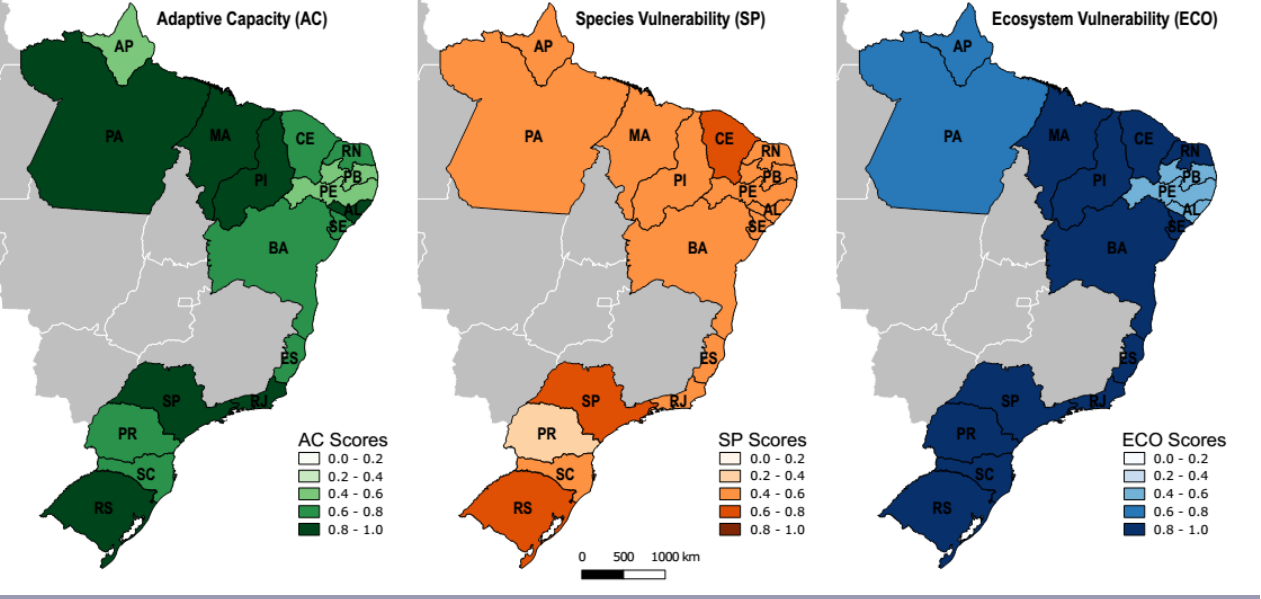
Fig. 4 . Maps with all coastal states colored by final Index of Coastal Vulnerability (ICV) component scores: adaptive capacity (green scale), species vulnerability (orange scale), and ecosystem vulnerability (blue scale). All component scores were divided into 5 categories, with the lowest values represented by the lightest shades of the color scale. For the AC score only, the lower the value, the worse the situation. State acronyms: AL, Alagoas; AP, Amapá; BA, Bahia; CE, Ceará; ES, Espírito Santo; MA, Maranhão; PA, Pará; PB, Paraíba; PE, Pernambuco; PI, Piauí; PR, Paraná; RJ, Rio de Janeiro; RN, Rio Grande do Norte; RS, Rio Grande do Sul; SE, Sergipe; SC, Santa Catarina; SP, São Paulo.